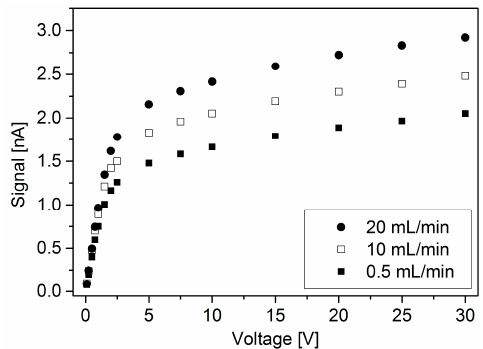
Figure 8. Channel 3 signal with variation of voltage on copper electrodes for various gas sample flow-rates. Uncertainty bars are not displayed in the graphic since their size is small compared to the symbols representing the points.